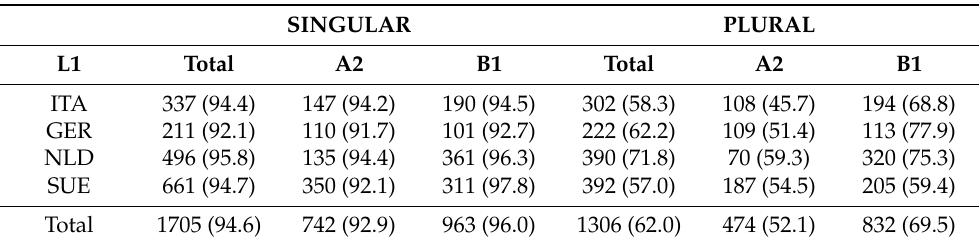
Table 4. Number of correctly agreeing verb forms in singular and plural contexts (proportion correct agreement within